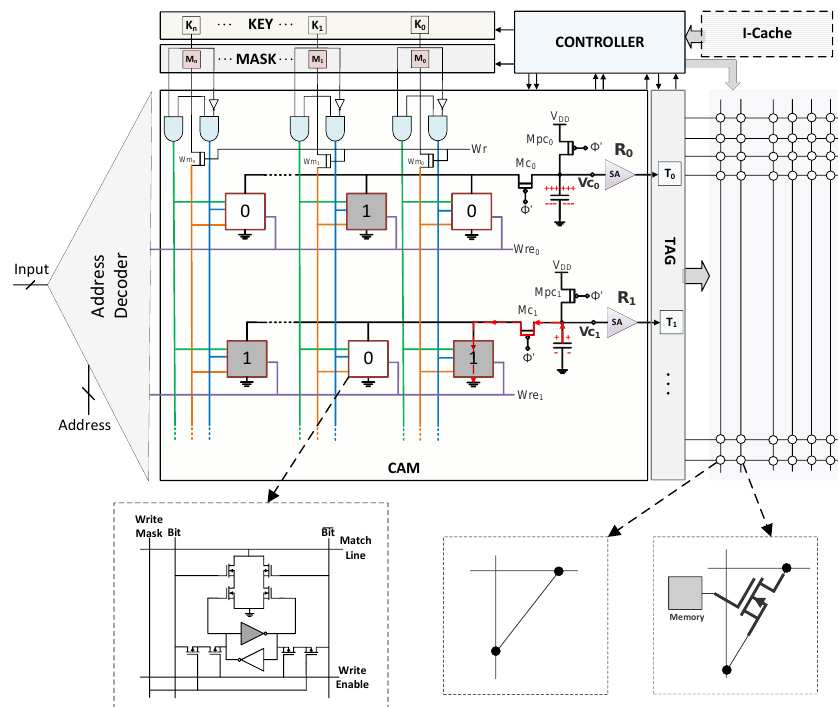
Figure 1. Associative processor